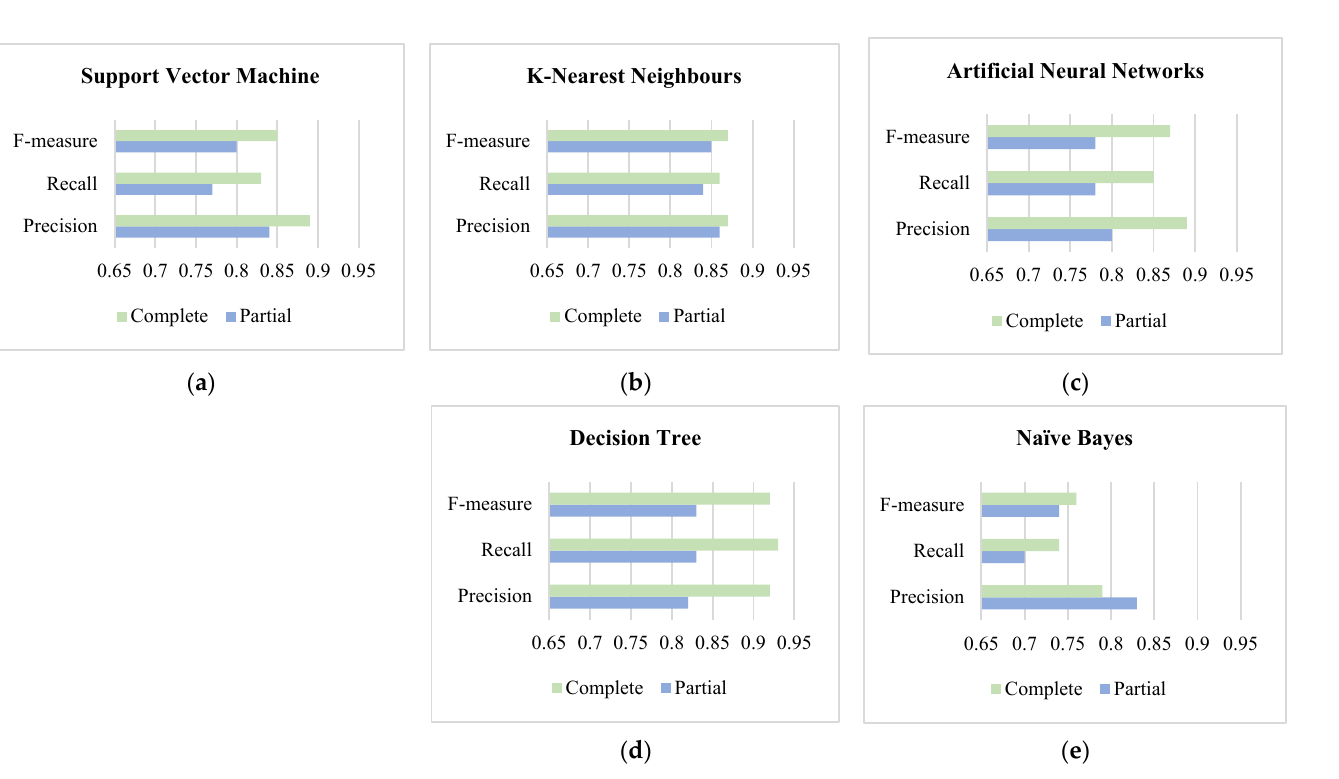
Figure 6. Comparison of the machine learning models between partial and complete hyperparameter tunings based on precision, recall, and f-measure: ( a ) comparison of the macro avg of SVM models; ( b ) comparison of the macro avg of KNN models; ( c ) comparison of the macro avg of ANN models; ( d ) comparison of the macro avg of DT models; ( e ) comparison of the macro avg of NB models .